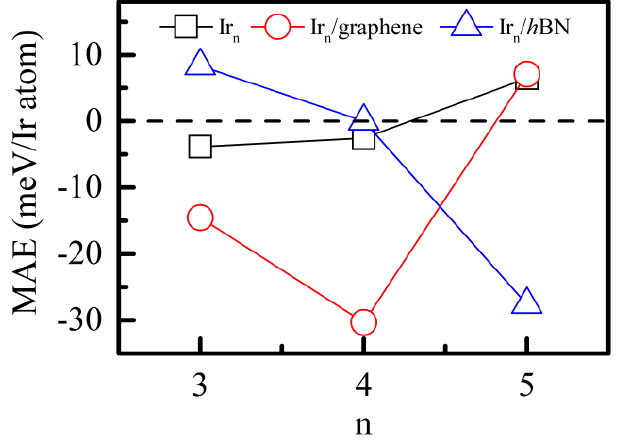
Figure 7. The MAE of the most stable free − standing Ir n and Ir n /2D systems (n = 3–5), respectively. The zero MAE is labeled by a dashed line.